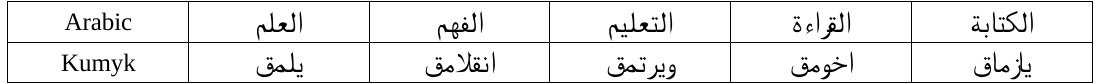
Table 2 - Lexical units identified in Arabic, Kumyk, Avar, and